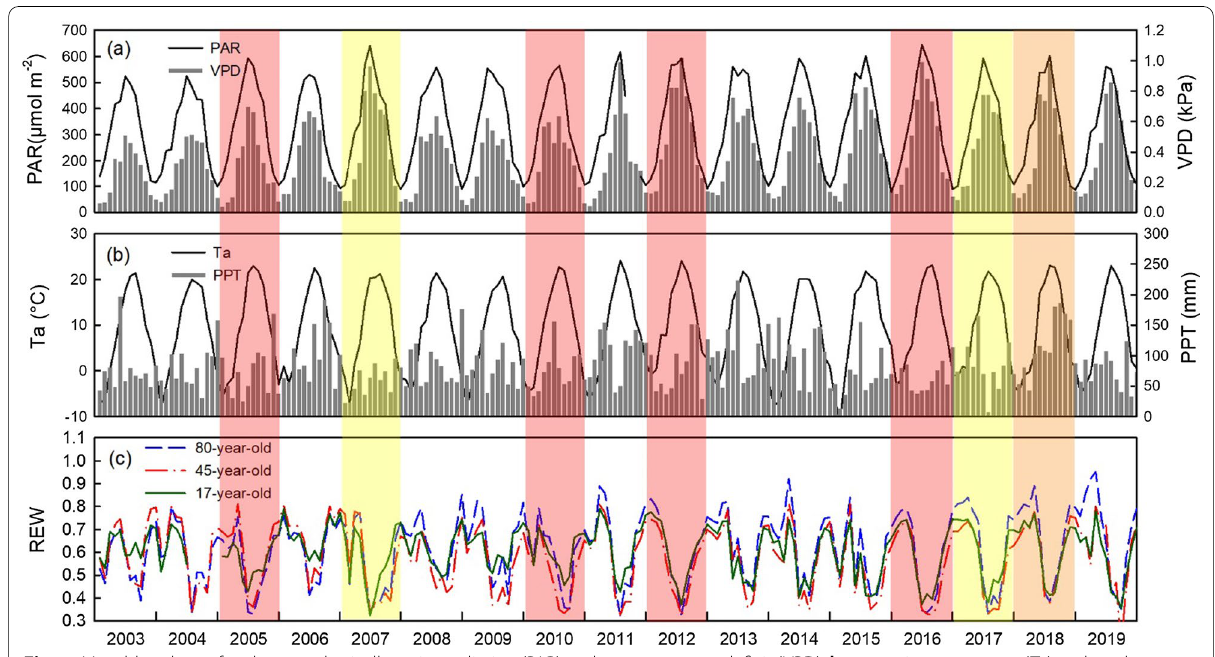
Fig. 1 Monthly values of a photosynthetically active radiation (PAR) and vapor pressure deficit (VPD), b mean air temperature (Ta) and total precipitation (PPT), and c soil Relative Extractable Water (REW) in the 0–30 cm soil layer at each site. Dry years are shaded as yellow (2007, 2017), hot year is shaded as orange (2018), and concurrent hot and dry years are shaded as red (2005, 2010, 2012 and